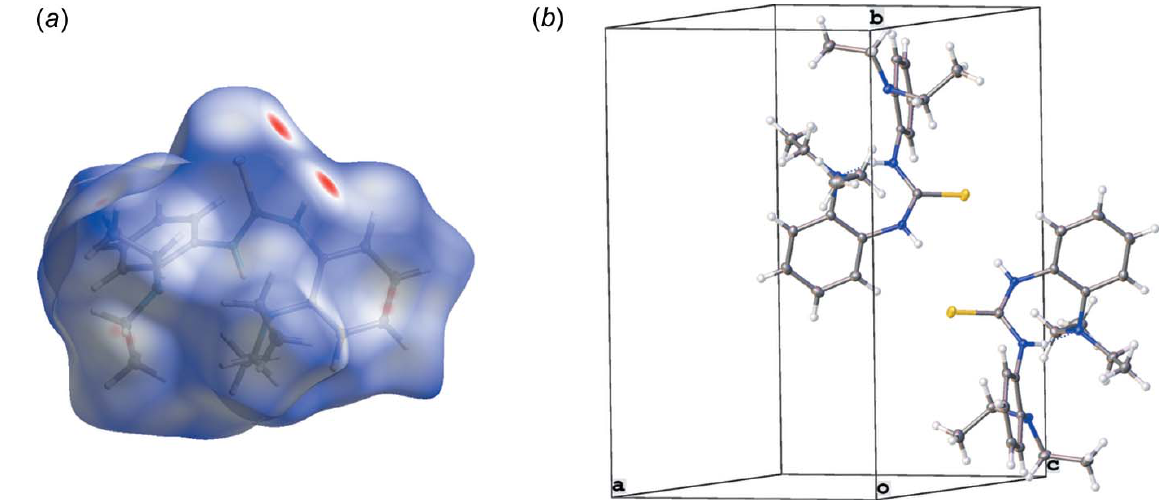
Figure 4 ( a ) Hirshfeld surface mapped over d norm in the range (cid:2) 0.18 to 1.48. ( b ) Partial packing plot of 2